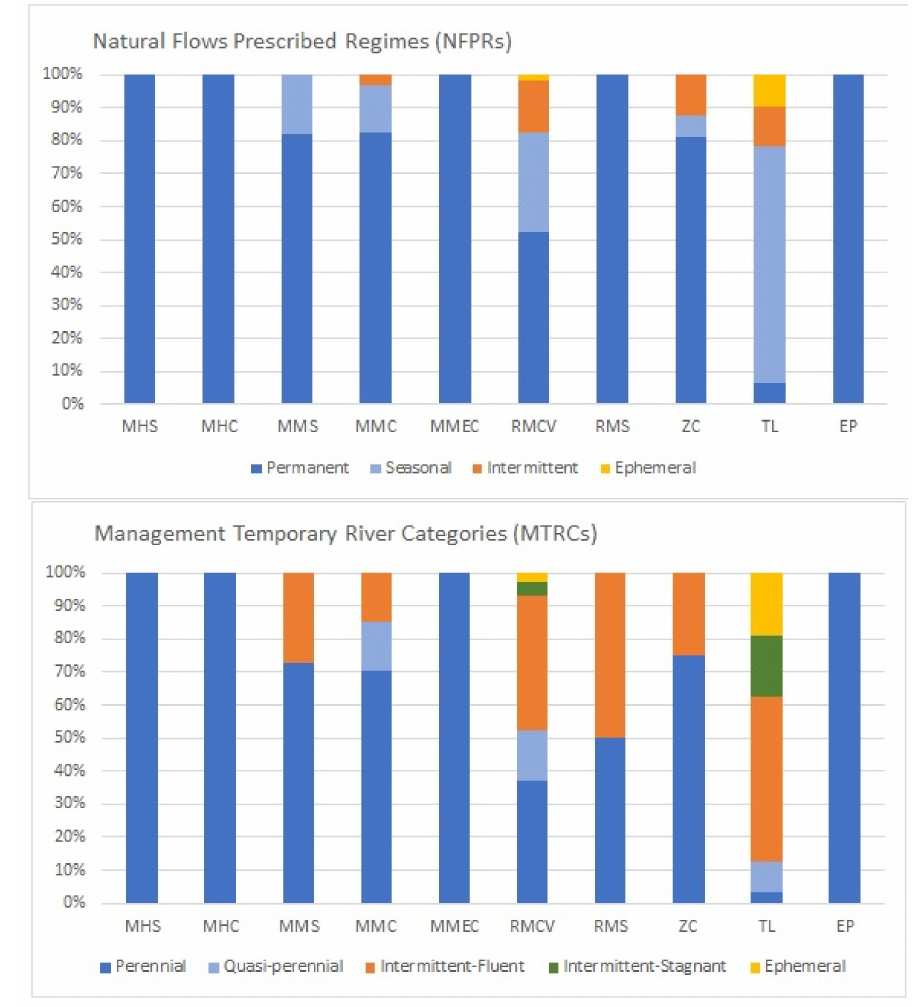
Figure 4. Percentage of river water bodies classified according to: (i) “natural flows prescribed regimes” (NFPRs) established by using a rainfall-runoff model (above); and (ii) “management temporary river categories” (MTRCs) provided from TREHS software (below), in each national river type (NRTs) set in the Catalan